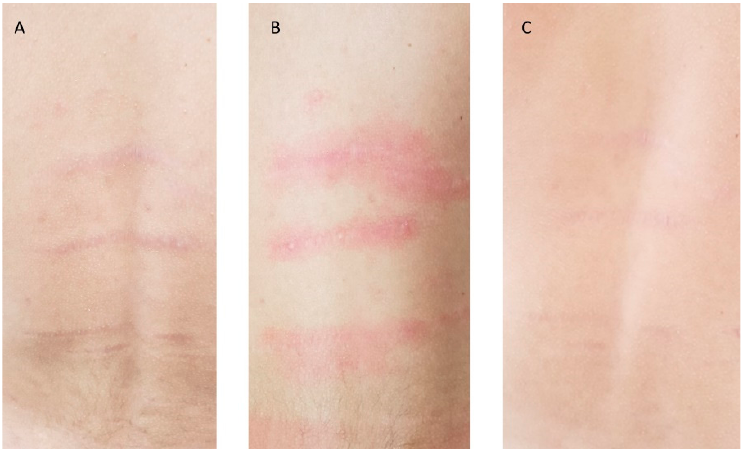
Figure 3. Photographic image of a male patient’s back area with Striae distensae (SD) before treatment ( A ), immediately after treatment ( B ), and 6M FU ( C ) after the last treatment with Nd:YAP 1340 nm laser. A visible and excellent aesthetic improvement of SD is shown.